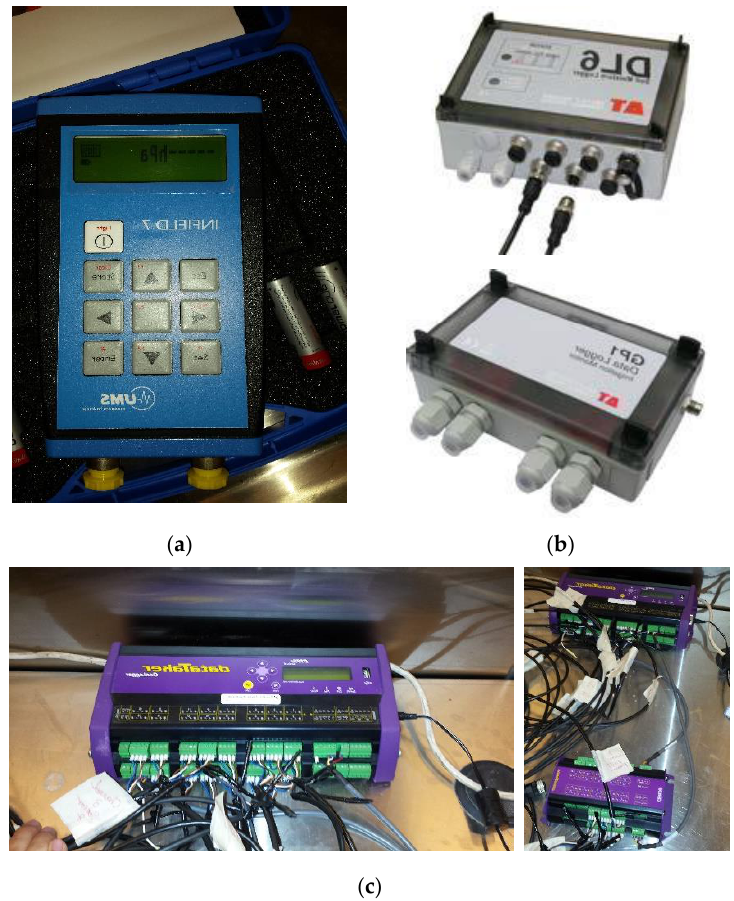
Figure 7. Three data logging systems for T5 tensiometers: ( a ) the Infield 7 hand reader provided by UMS [65]; ( b ) the 6-channel DL6-te and dual-channel GP1-te data loggers provided by UMS [65]; ( c ) the 18-channel DT85g Series 3 DataTaker GeoLogger linked with the 20-channel CEM20 channel expansion board, allowing a maximum number of 37 analogue channels connected to sensors [68].